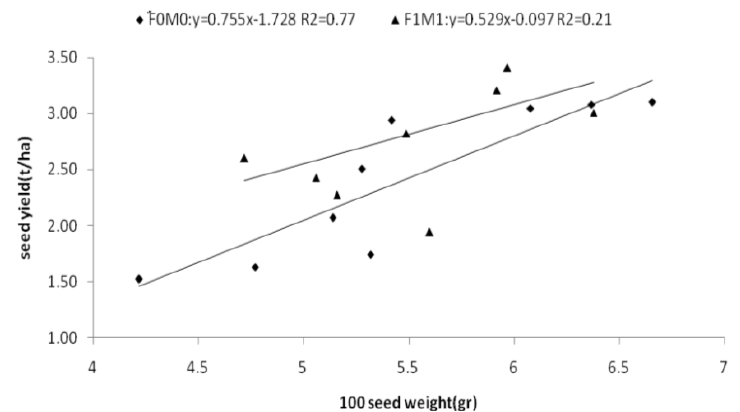
Fig. 5. Relationship between seed yield and 100 seed weight in case of Mn and Fe (F M ) together, and lack of Mn and Fe (F 1 1